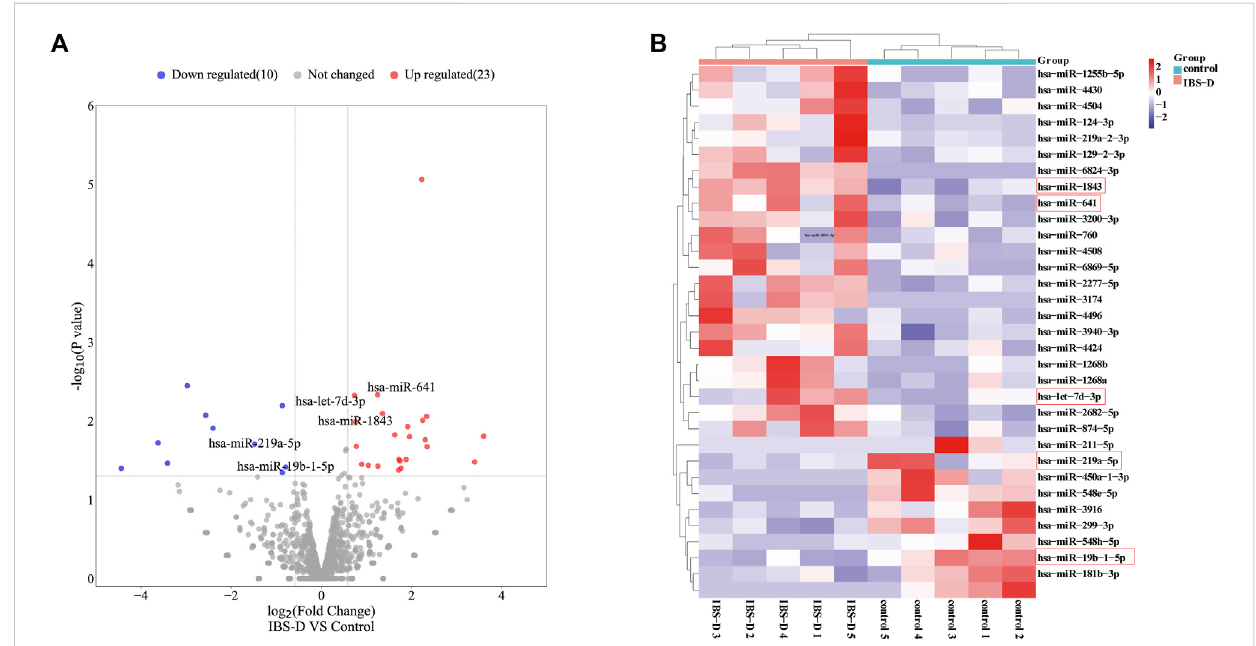
FIGURE 1 Differentially expressed miRNAs in IBS-D. (A) Volcano map of the differentially expressed miRNAs. IBS-D group versus control group. (Red: upregulated miRNAs; Blue: downregulated miRNAs; Grey: non-differentially expressed miRNAs). (B) Heat map of the 33 differentially expressed miRNAs with p < 0.05 (Red box: miRNAs were found to be expressed in a signi fi cantly different manner).